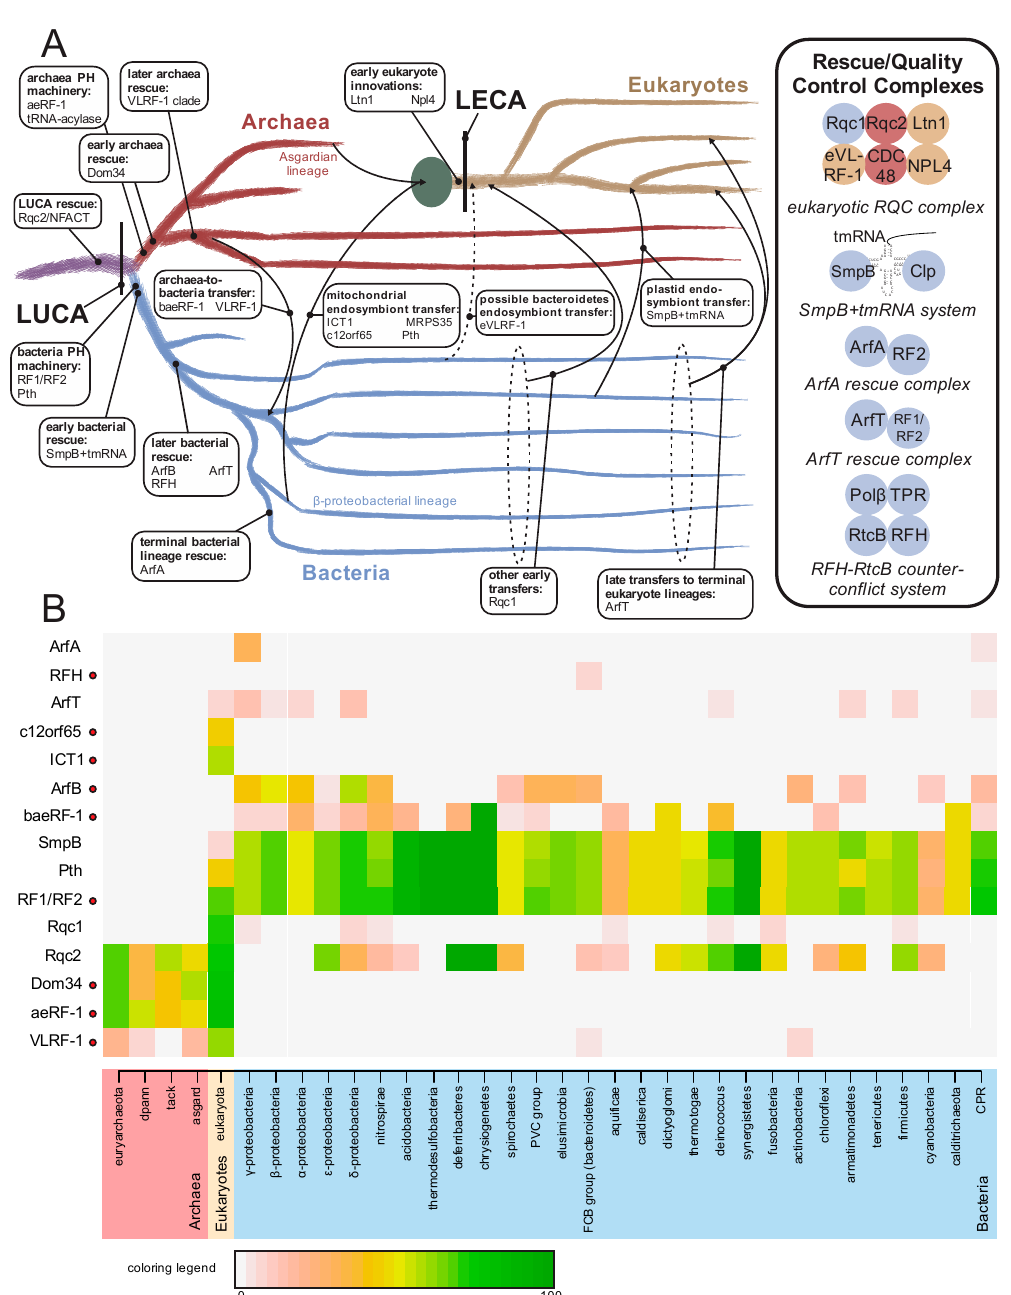
Figure 5. ( A ) Evolutionary origins and trajectories of release factors and ribosome rescue pathways, with factors listed at points of emergence/transfer. Transfer events are depicted with arrows and labeled; when timing is unclear the lines are broken. The mitochondrial endosymbiotic event is represented by a large green circle. Complexes formed by release/rescue factors are depicted to the right. Circles are color-coordinated with tree to represent the superkingdom of origin of a component. ( B ) Relative presence/absence for individual components of the ribosome quality control and rescue pathways. Presence/absence is colored by percentage of genomes within taxa which contain a given component. Names of taxa are colored by superkingdom. Components containing a RF-PH domain are marked to the right of their name by a red circle. Abbreviations: tack, Thaumarchaeota, Crenarchaeota, and Korarchaeota superphylum; dpann, Diapherotrites, Parvarchaeota, Aenigmarchaeota, Nanoarchaeota, and Nanohaloarchaea superphylum; PVC group, Chlamydiae, Lentisphaerae, Planctomycetes, and Verrucomicrobia bacterial superphylum; FCB, Fibrobacteres, Bacteroidetes, and Chlorobi superphylum; CPR, Candidate Phyla